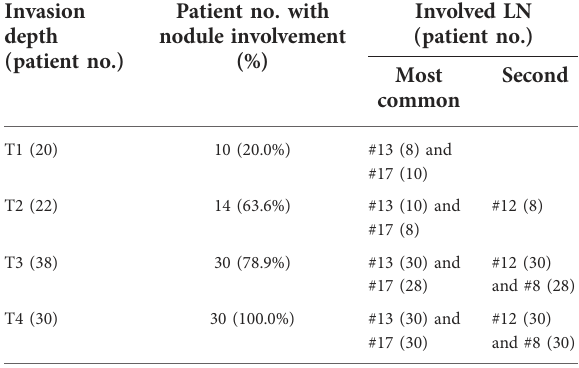
TABLE 3 The correlation of positive LN with invasion depth.